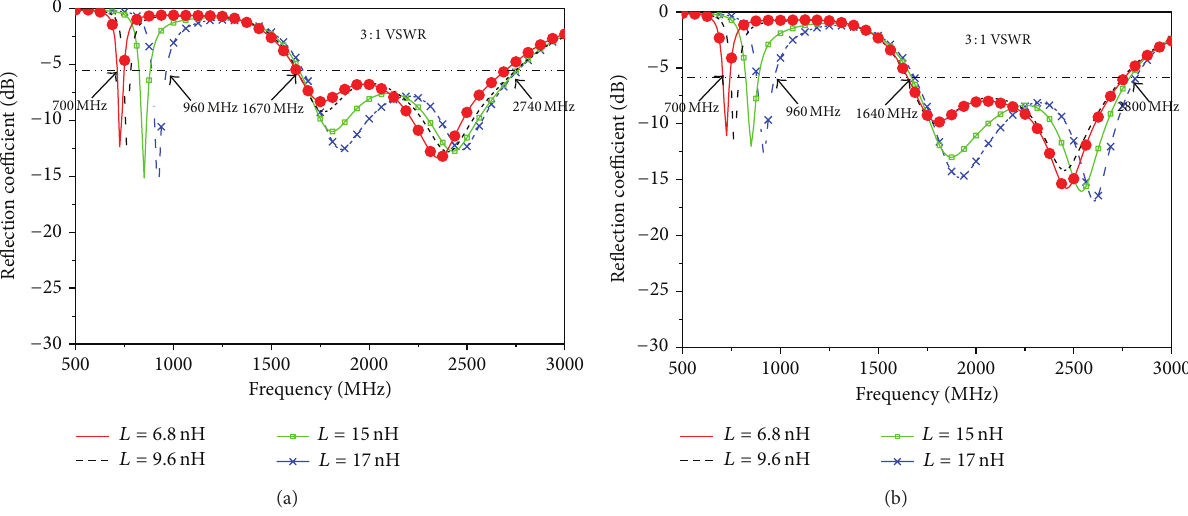
Figure 4: Simulated and measured reflection coefficient against frequency for the proposed antenna. (a) Simulated results. (b) Measured